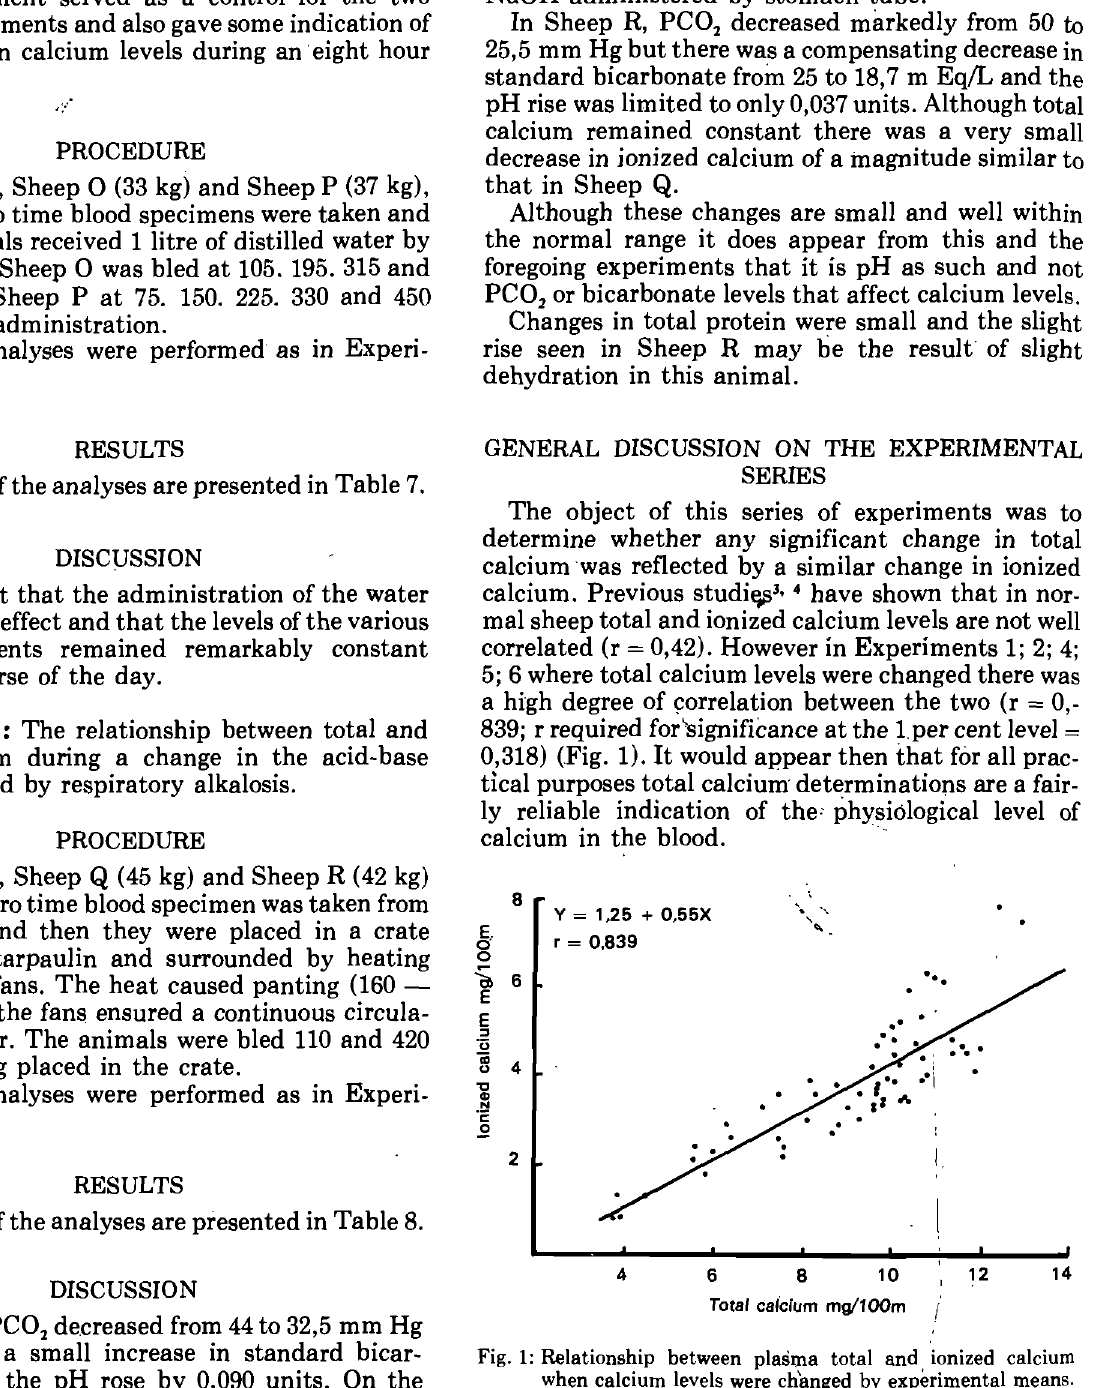
Fig. 1: Relationship between plasma total and ionized calcium when calcium levels were changed by experimental means. AND STANDARD 2